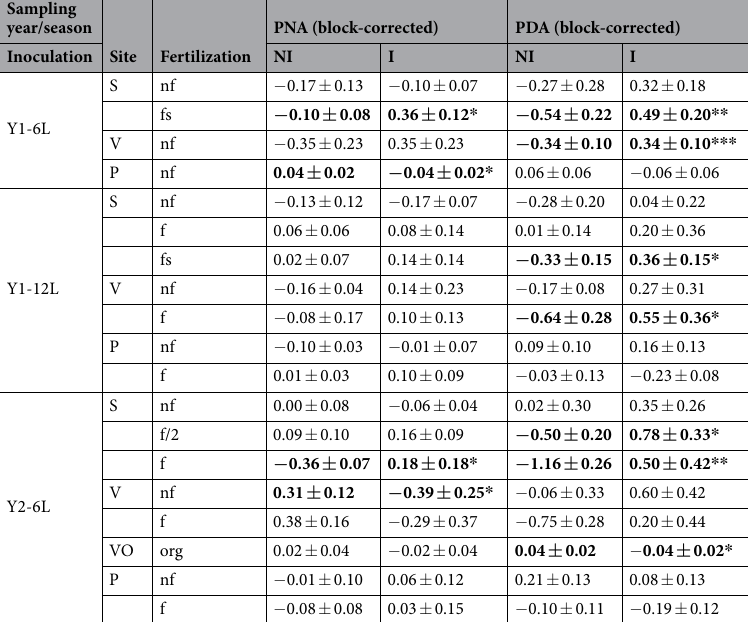
plots at Y1-6L (p < 0.001) and V-f plots at Y1-12L (p < 0.05). However, it slightly decreased in VO plots at Y2-6L (Table 2). No significant effect of inoculation on PDA was observed in the other plots. Effects of inoculation on nitrifier and nitrite-reducer abundances. The abundances of AOB and AOA were of the same order of magnitude (i.e. typically from 1 to 5 × 10 7 amoA copies g − 1 dry soil for both groups, Supplementary Fig. S3) and were significantly correlated between each other (p < 0.001) only at Y2-6L sampling date. AOA abundances were significantly influenced by inoculation only at Y1-6L sampling date in P-nf. In contrast, AOB abundances were not significantly affected by inoculation at any time (data not shown). The abundances of nirK - and nirS -harbouring denitrifiers are reported in Supplementary Fig. S4. The abun- dances of both groups were similar in S and VO soils, whereas the abundance of nirK -denitrifiers was around 10-fold higher (respectively 2–3 fold-lower) than the abundance of nirS -denitrifiers in P (respectively V) soil (Supplementary Fig. S4). The abundances of the two nitrite reducer groups were correlated between each other at Y1-6L and at Y2-6L sampling dates (p < 0.05) but not at Y1-12L. The abundance of nirK -denitrifiers was influ- enced by inoculation at Y1-12L in S-f plots and at Y2-6L in P-nf (p < 0.05), whereas nirS -denitrifier abundance was significantly affected by inoculation at Y1-6L and Y1-12L in S-fs plots, and at Y2-6L in S-f/2 plots (p < 0.05). No significant inoculation effect was observed in the other plots.